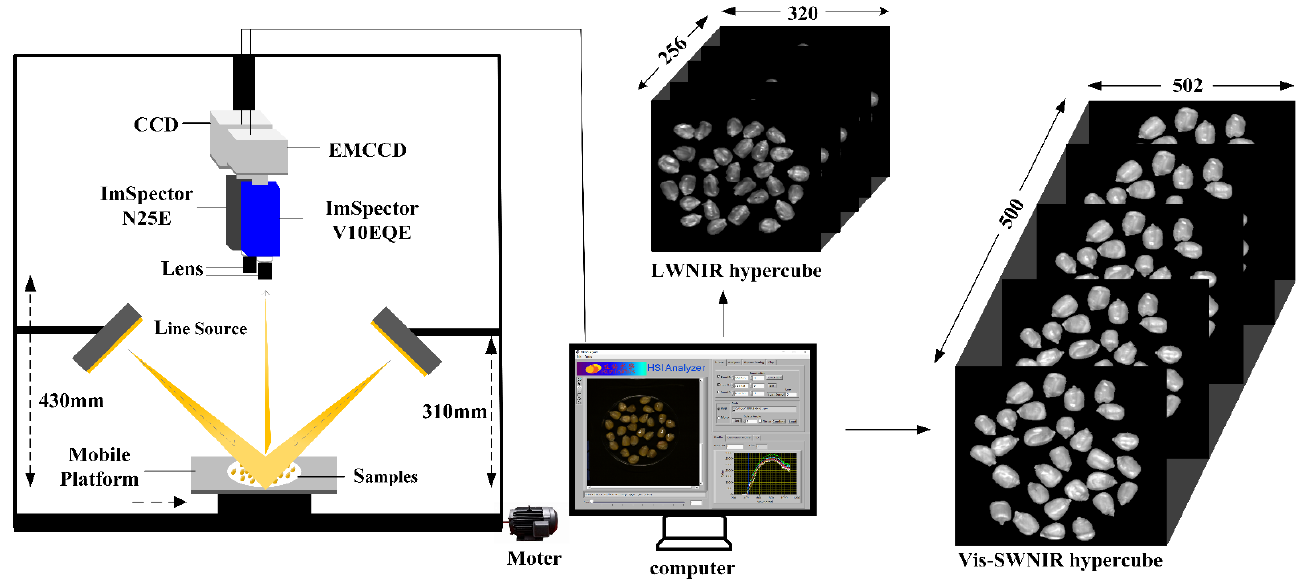
Figure 1. Hyperspectral image acquisition system.